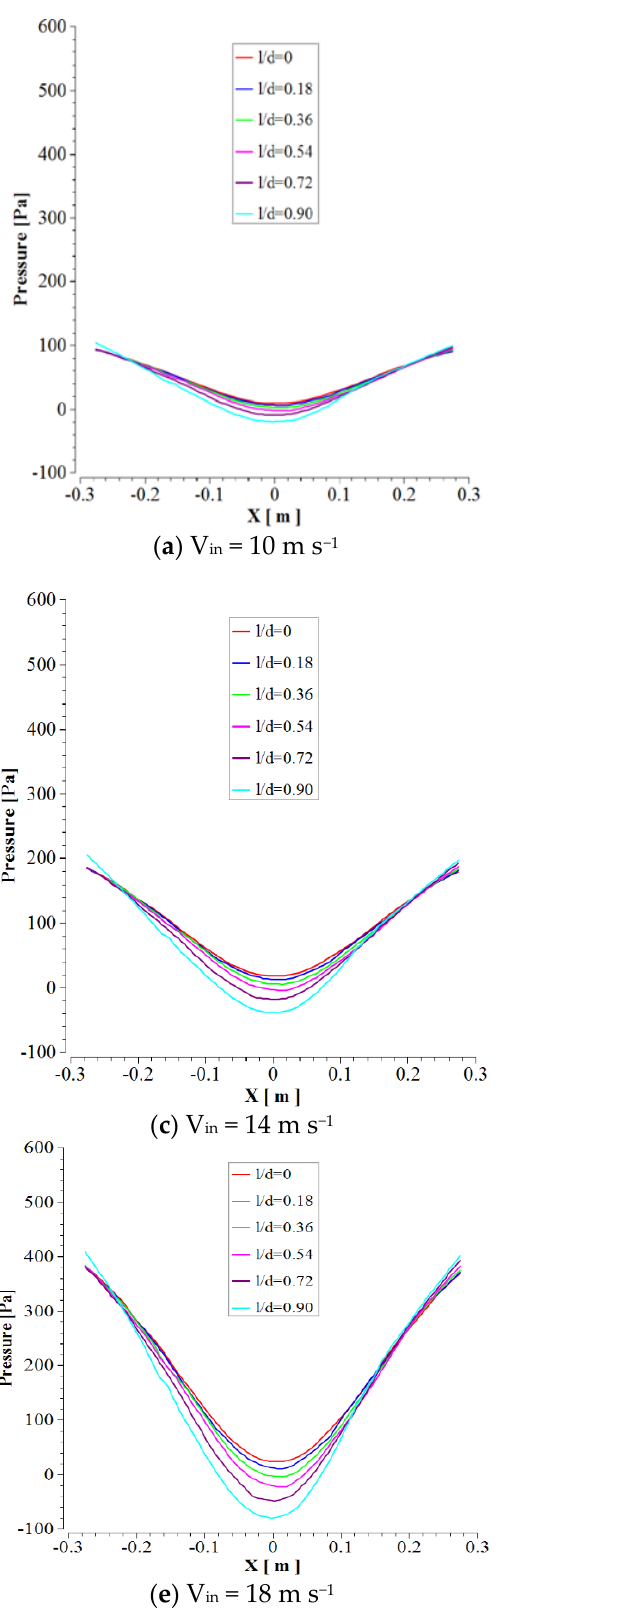
Figure 15. Static pressure contour in various inlet velocities. Additionally, the pressure drops plots in six various heights of cyclones (l/d = 0, l/d = 0.18, l/d = 0.36, l/d = 0.54, l/d = 0.72, l/d = 0.9) are illustrated in Figure 16.